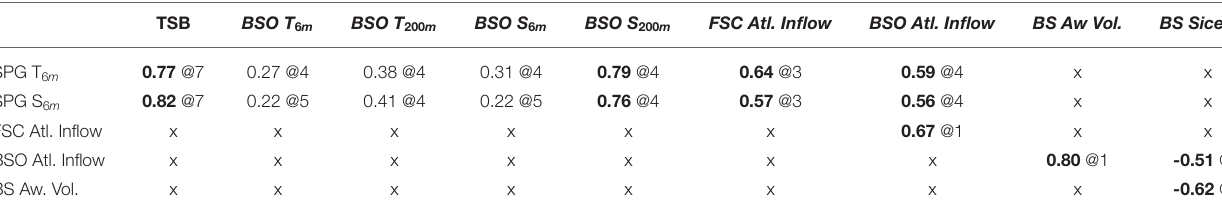
TABLE 1 | Pearson’s correlation coefficients (r) among various variables and the lag at which r is maximum (@Lag (years)). FSC Atl. Inflow BSO Atl. Inflow BS Aw Vol. BS Sice.